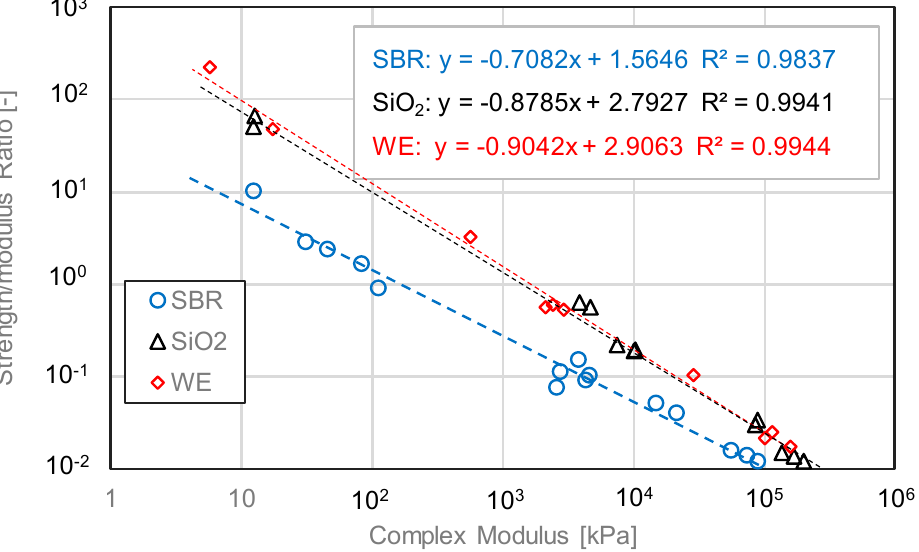
Figure 20. The measured ratio between bonding strength and complex shear modulus.